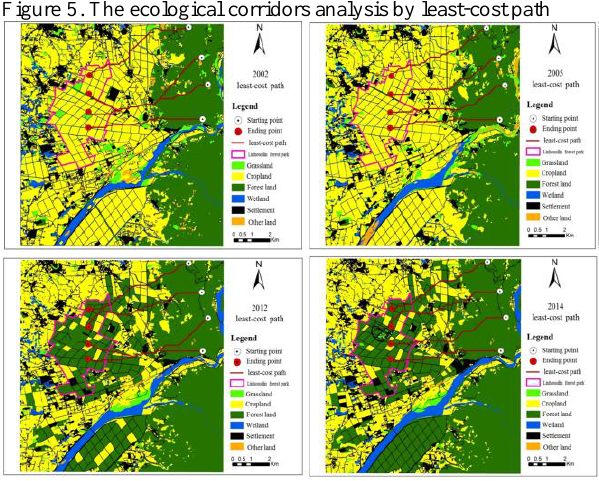
Figure 5. The ecological corridors analysis by least-cost path